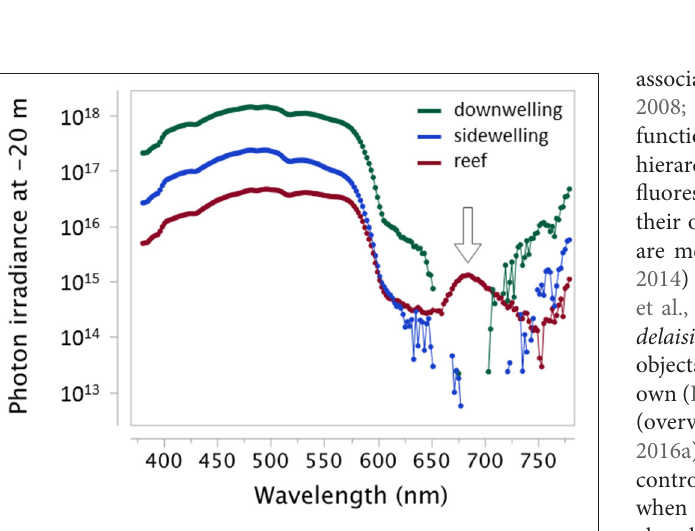
FIGURE 2 | One positive and two negative cases of “patchy fluorescence.” The devil scorpionfish (A,B) is a typical motionless sit-and-wait predator with patchy fluorescence that appears similar to that of its background. (C) and (D) exemplify red fluorescent benthic species scored as “negative” for patchy fluorescence. Picture (A) taken without filter, the others with a LEE 164 Flame red filter to enhance long wavelengths, all at ∼ − 20m with manual white balance (Photos: Nico K. Michiels).